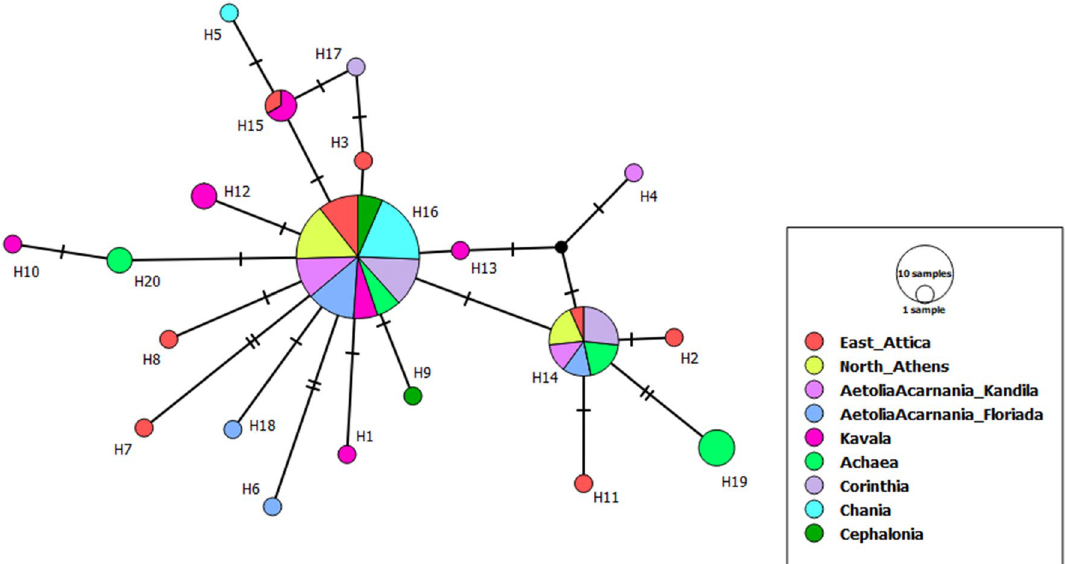
Figure 1. Haplotype COI network of Philaenus spumarius from Greece obtained from TCS analysis with PopART v.1.7 (http://popar t.otago .ac.nz). Each colour indicates a different geographic area. Size of the circles represent the frequency of each haplotype among individuals. Hatch marks along the branches indicate the numbers of mutations and black dots represent unsampled and hypothetical haplotypes. Size of the lines are in proportion with the number of base substitutions.